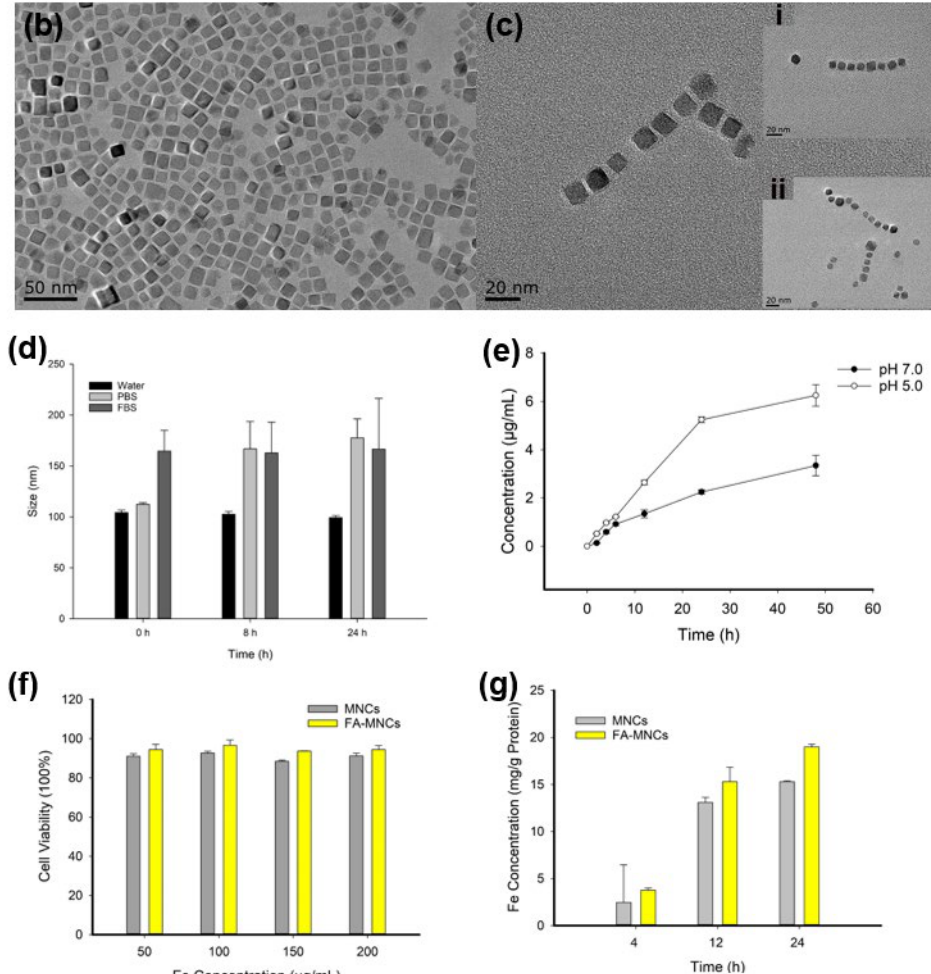
Figure 2. Construction of magnetic chain-like nanochains. ( a ) Schematic diagram of fabrication process by the solvent exchange method and the magnetostatic field-directed assembly. ( b ) TEM image of the original oleic acid@Fe 3 O 4 nanoparticles. ( c ) TEM image of the fabricated magnetic chain-like nanochains. ( d ) The hydrodynamic size of magnetic nanochains in pure water, PBS and 10% serum medium at 0, 8 and 24 h, respectively. ( e ) Drug release profile of the nanochains in acidic and neural media, respectively. ( f ) Concentration dependent cytotoxicity to K562 cells of nanochains and FA-modified nanochains for 24 h. ( g ) Endocytosis of K562 cells to nanochains and FA-modified nanochains at four, 12, and 24 h, respectively. Data are presented as mean ± SD.